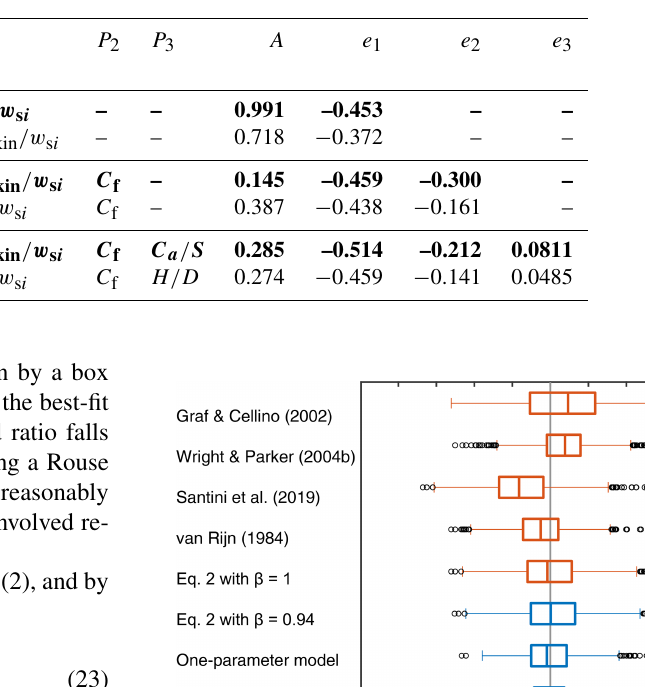
Figure 5. Best-fit models for the Rouse number for grain-size-specific data with one parameter (a) , two parameters (b) , and three parame- ters (c) ; equations are in bold in Table 4. The plotting is done such that the exponent on the last parameter is unity; e.g., Eq. 23 in panel (b) (cid:18) (cid:19) − 0 . 3 (cid:16) u (cid:17) − 0 . 46 / − 0 . 3 ∗ skin C f to allow for comparison to plots of Garcia and Parker (1991) and Wright was rewritten as P i = 0 . 145 1 / − 0 . 3 w s i and Parker (2004b). Yellow filled symbols are the geometric mean, and the error bars indicate the geometric standard deviation within each arbitrarily spaced bin. P e 2 P e 3 . The two best-fitting versions of each Table 4. One-, two-, and three-parameter models for the Rouse number of the form P i = AP e 1 1 2 3 model are shown, one with u ∗ and one with u ∗ skin , and the bold value is the best fitting of the two (highest r 2 ). See Table S2 for all model fits.